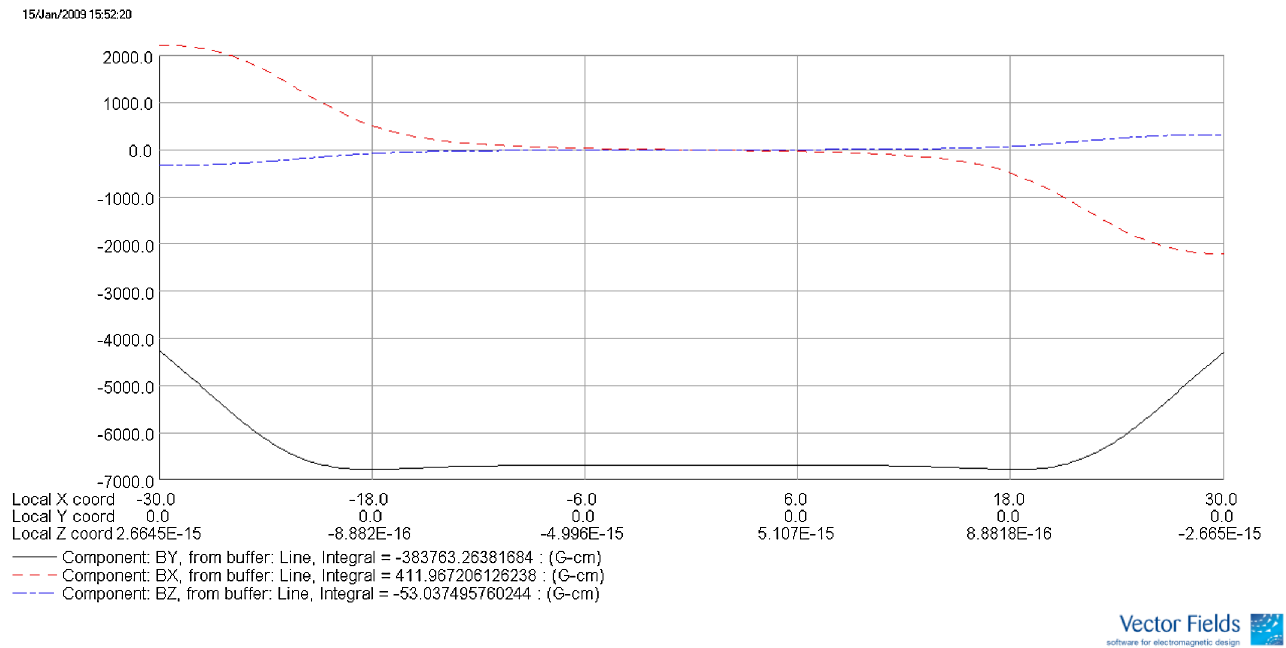
FIG. 6. (Color) Magnetic field across ELS gap at its